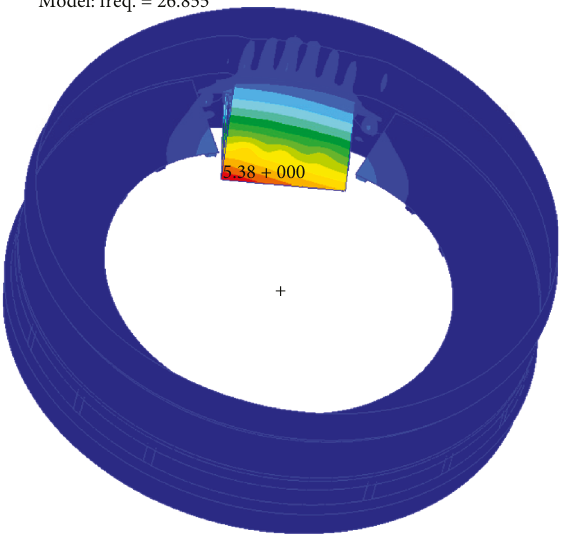
Figure 13: First modal shape of the equipment bay